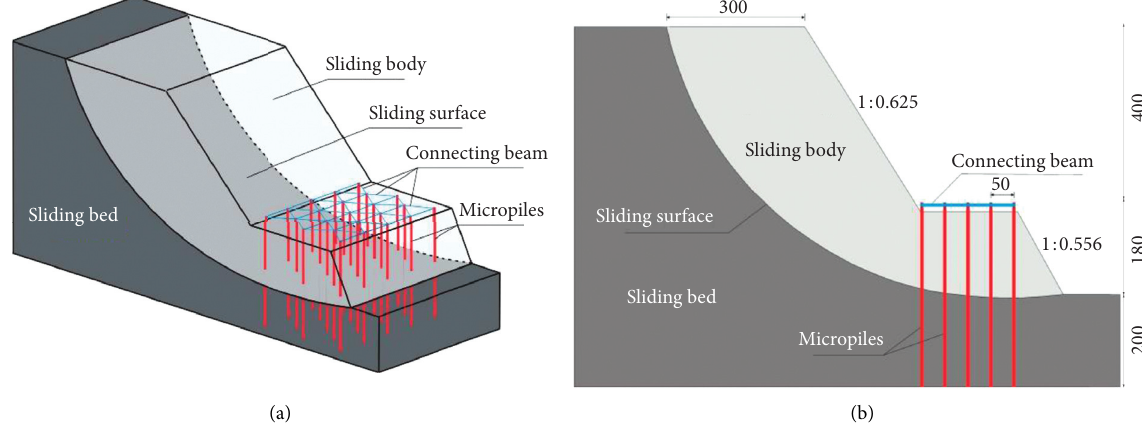
Figure 1: Schematic diagram of the test model. (a) Schematic diagram of the test model; (b) sectional view of the model (unit: